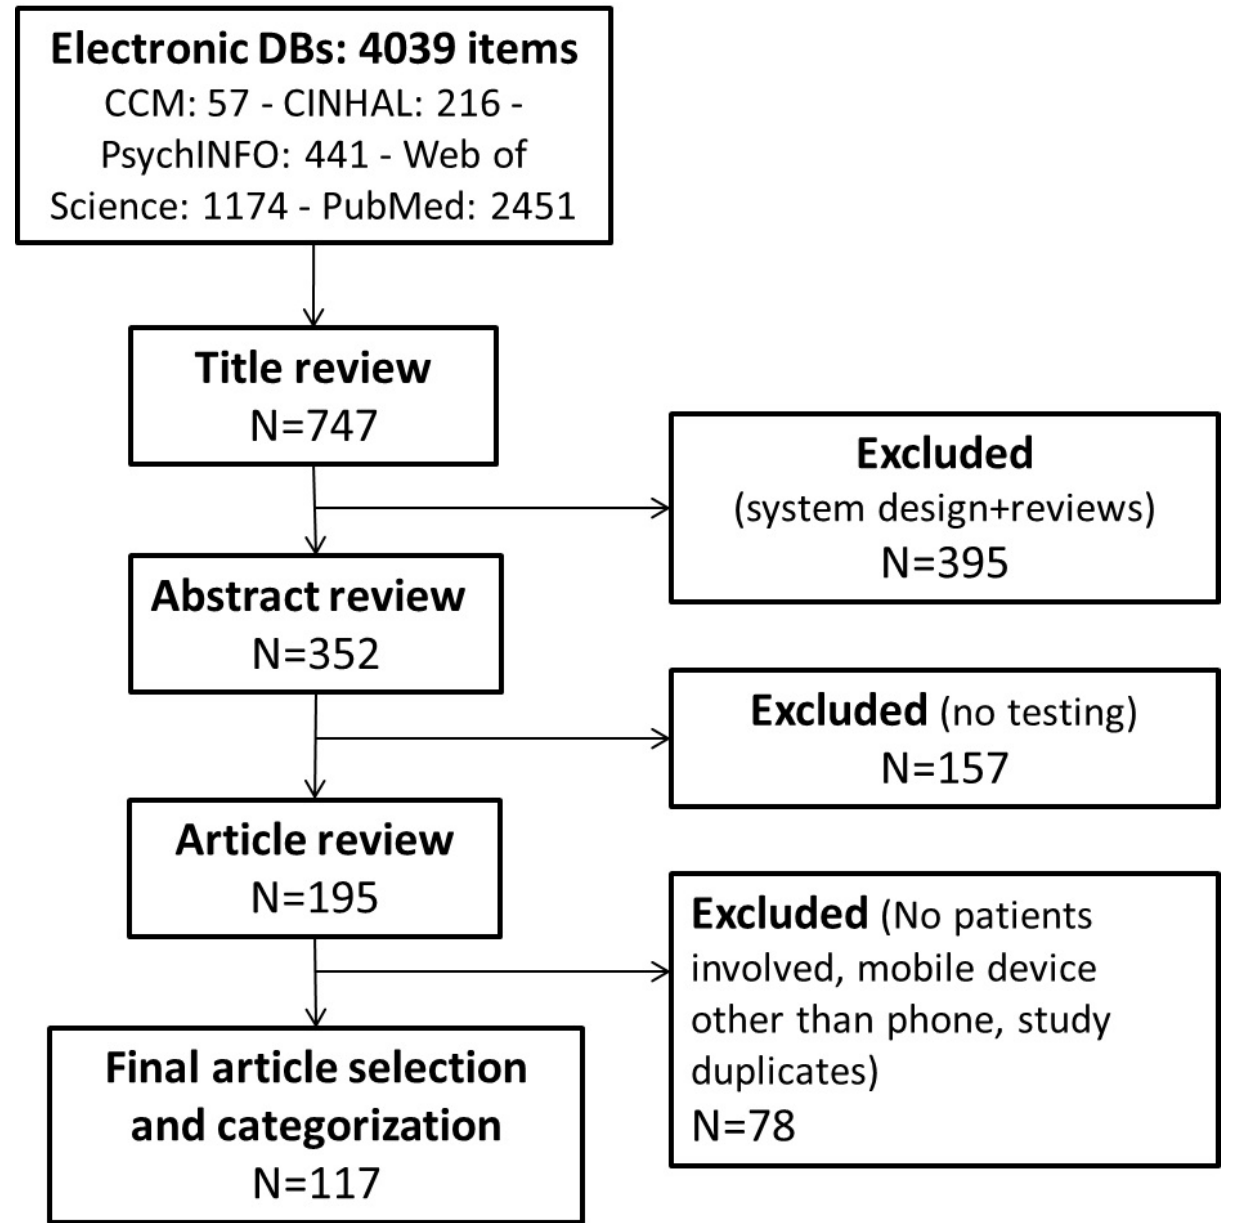
Figure 1. Summary of literature search and review